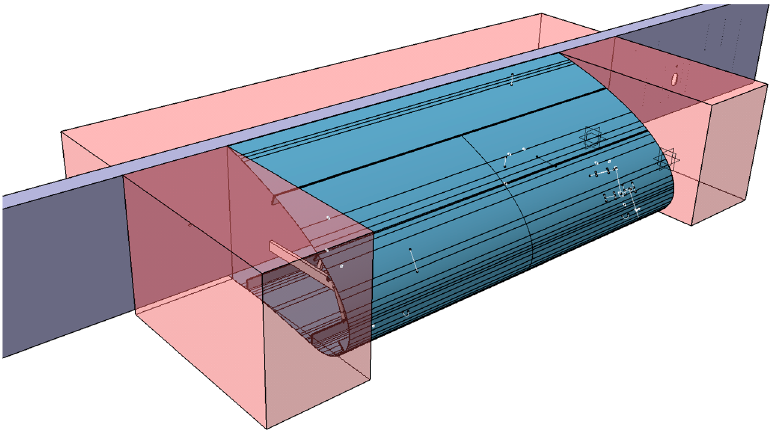
Figure 28. Space inaccessible for assembly.